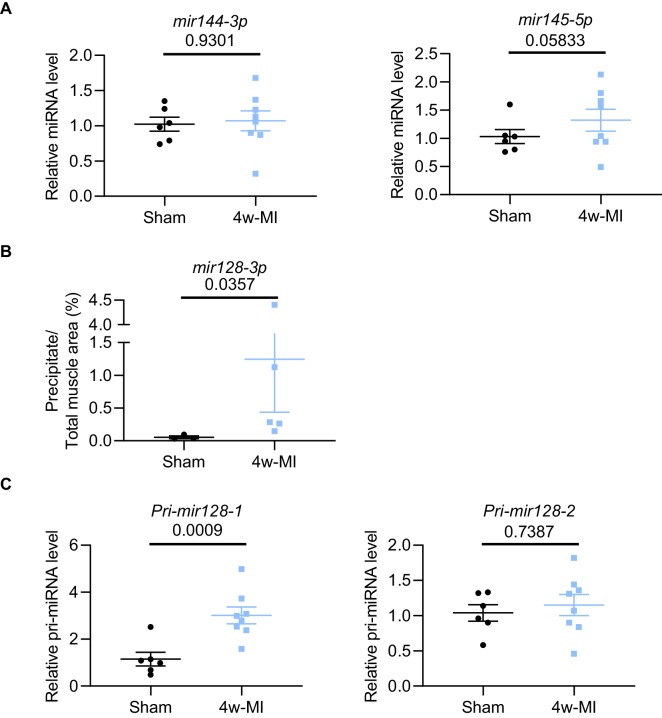
MiRNA analysis in 4w-MI myocardium.(A) Mature mir144-3p and mir145-5p in 4w-MI myocardium were measured using TaqMan Advanced miRNA qPCR (N = 6–8 mice). Data were normalized against mature mir191-5p expression. (B) In situ hybridization with digoxigenin-labeled mir128-3p probes was quantified using ImageJ software (N = 3–5 mice). Groups were compared using the Mann-Whitney test. (C) Pri-mir128-1 and Pri-mir128-2 measurement in 4w-MI myocardium using TaqMan Gene expression (N = 6–8 mice). Data were normalised against 18S expression. Data presented as mean ± SEM. Groups were compared using two-tailed Student’s t-test.Figure 2—figure supplement 1—source data 1.MiRNA analysis in 4w-MI myocardium.